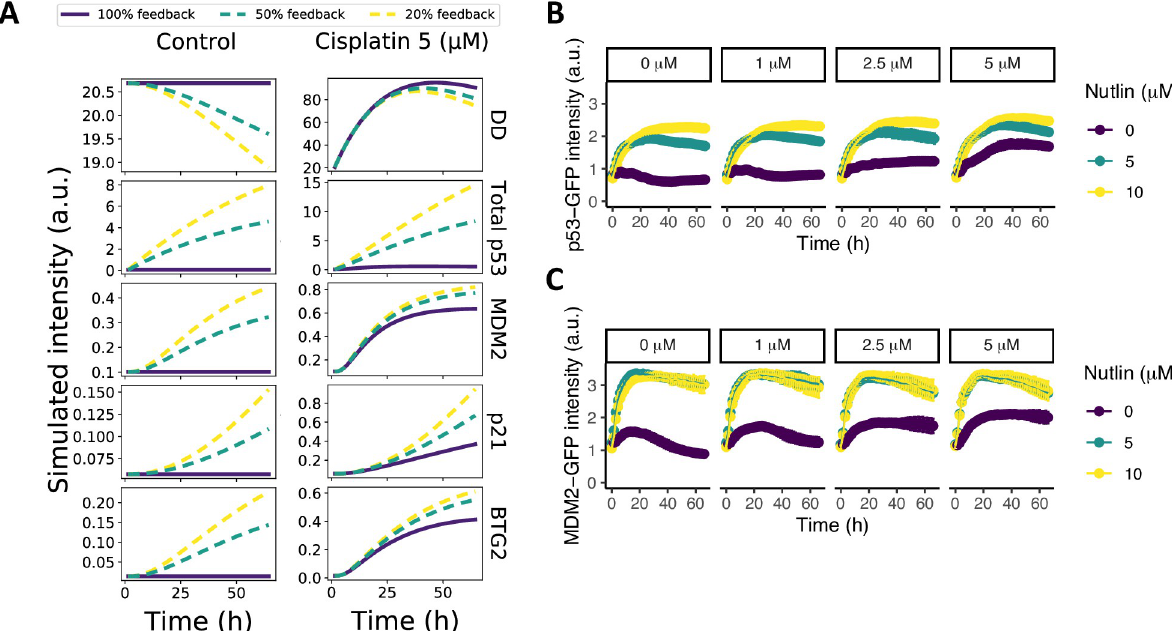
Fig 4. Reduced p53-MDM2 feedback promotes p53 and MDM2 expression. (A) Model simulations upon disruption of the MDM2-p53 feedback by weakening the feedback strength of MDM2 on p53 degradation to 50% (dashed green) or 20% (dashed yellow) of the original strength; simulations without disruption are shown as solid purple lines. (B-C) p53-GFP (B) and MDM2-GFP (C) expression in HepG2 cells after exposure to increasing concentrations of cisplatin (purple) and to cisplatin in combination with 5 (green) or 10 (yellow) μ M Nutlin, both administered at t = 0